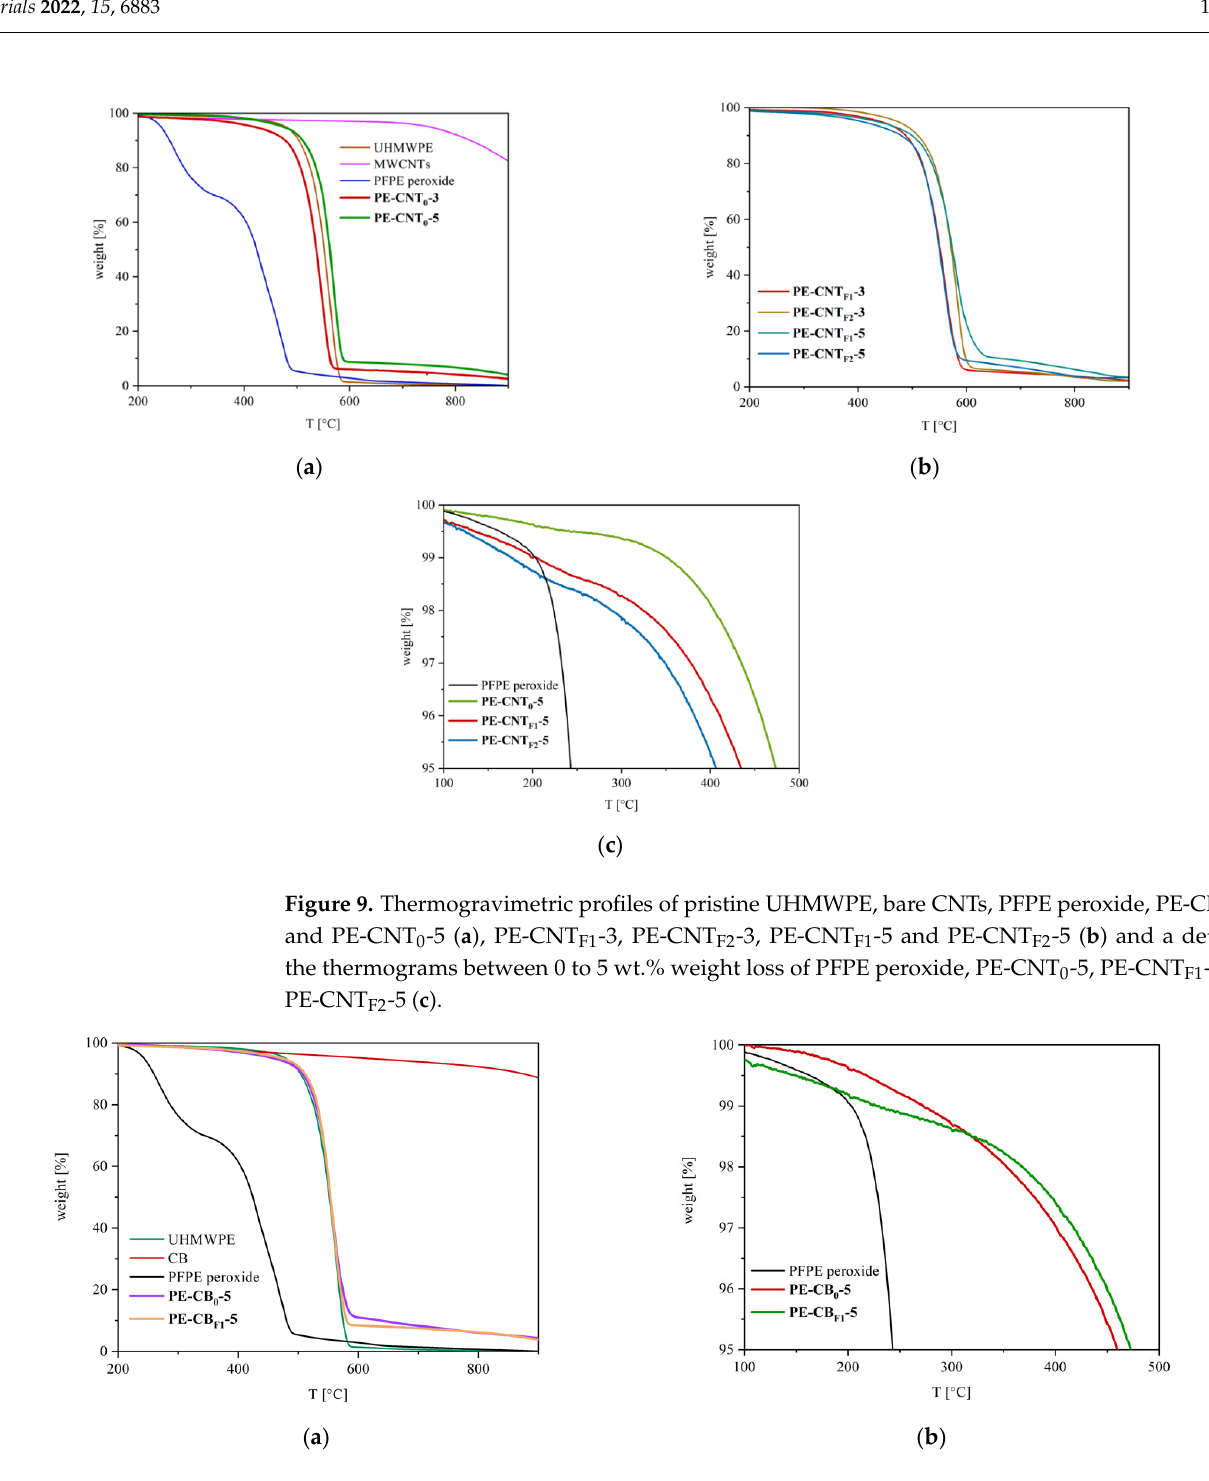
Figure 10. Thermograms of pristine UHMWPE, bare CB, PFPE peroxide, PE ‐ CB 0 ‐ 5 and PE ‐ CB F1 ‐ 5 ( a ) and a detail of the thermograms between 0 to 5 wt.% weight loss of PFPE peroxide, PE ‐ CB 0 ‐ 5 and PE ‐ CB F1 ‐ 5 ( b ).